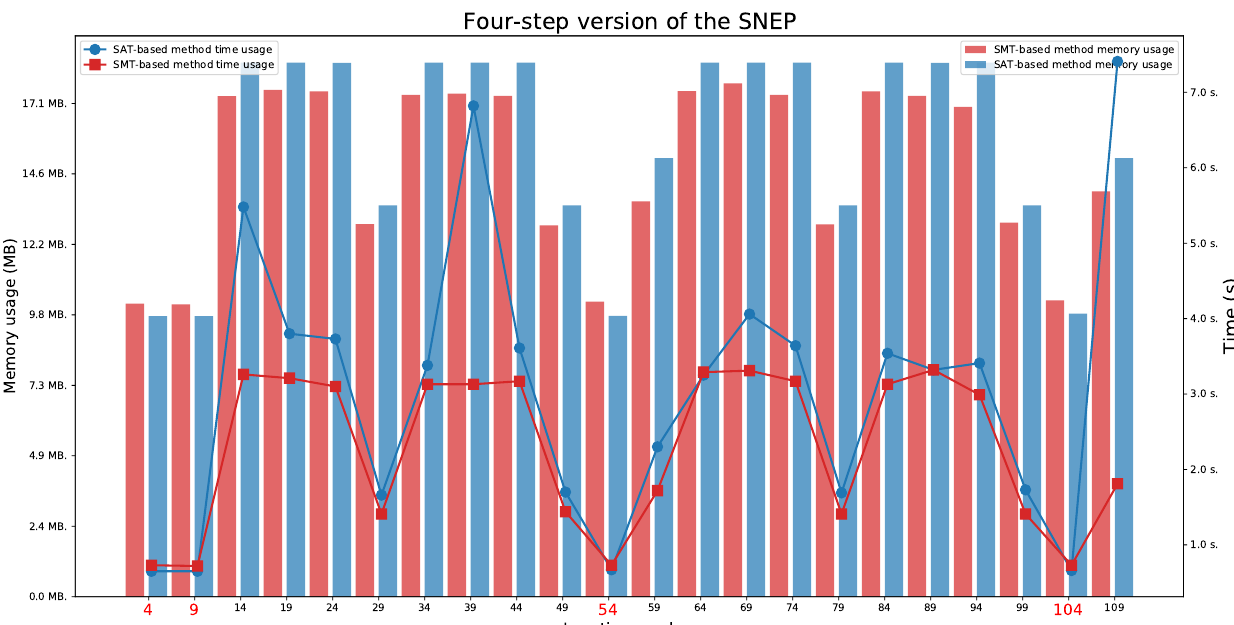
Figure 11. The four-step version of the SNEP: Time and memory usage for checking the last locations’ reachability in each execution automaton for the lifetime value equal to 4. The reachable states are marked in red.